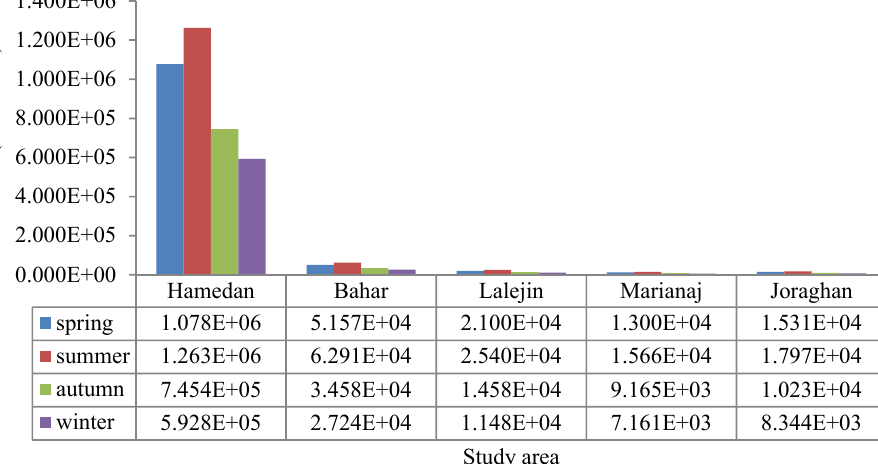
Fig. 6: Methane emission rate at different seasons in the study area Table 4: Potential of greenhouse gas emission (m 3 /y) from rapidly and slowly degradable organic wastes in the study area during 2011-2030 Rapidly degradable compounds Area